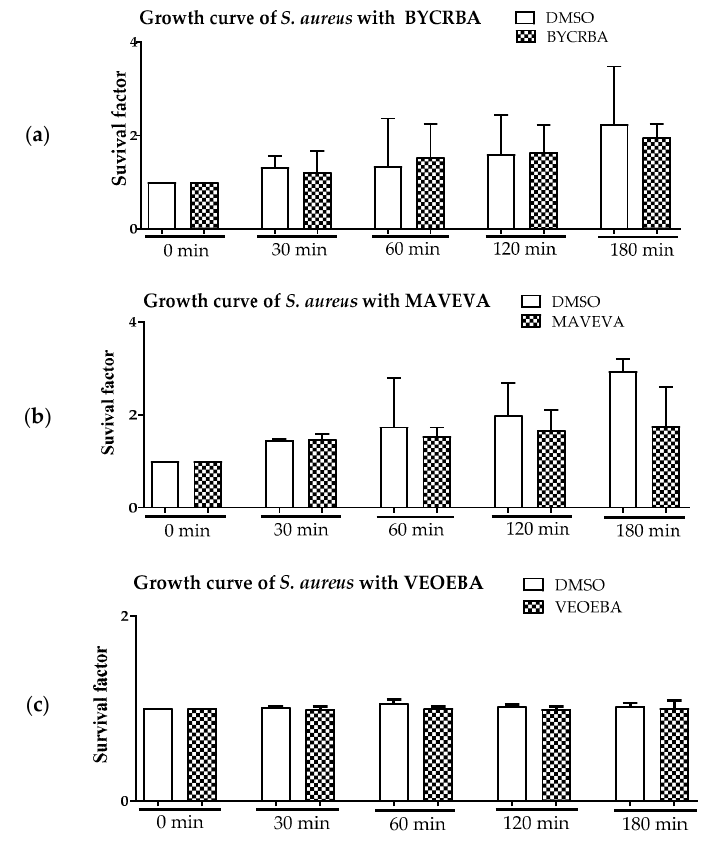
Figure 2. BYCRBA ( a ), MAVEVA ( b ), and VEOEBA ( c ) show no direct antimicrobial effect against S. aureus . Depicted are the bacterial survival factors at defined time points in comparison to t = 0 from n = 3 independent